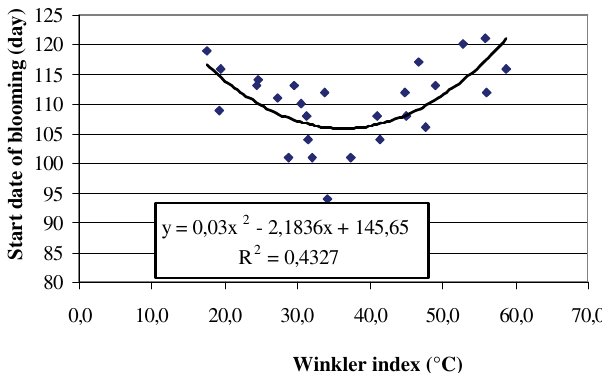
Figure 6. Relationship between the average value of Winkler index thirty days prior to blooming start and the start date of blooming at “Debreceni bôtermô” cultivar (Újfehértó